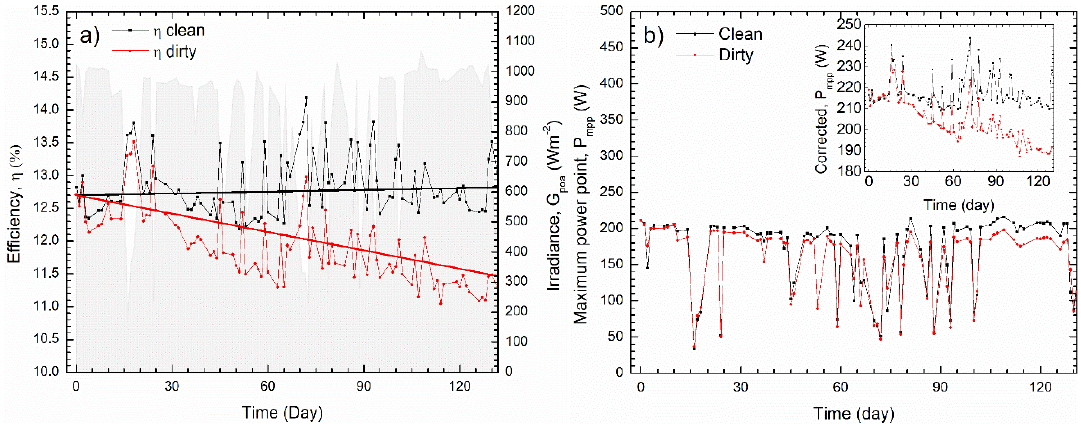
; ( b ) power at the maximum power point, 𝜂𝜂